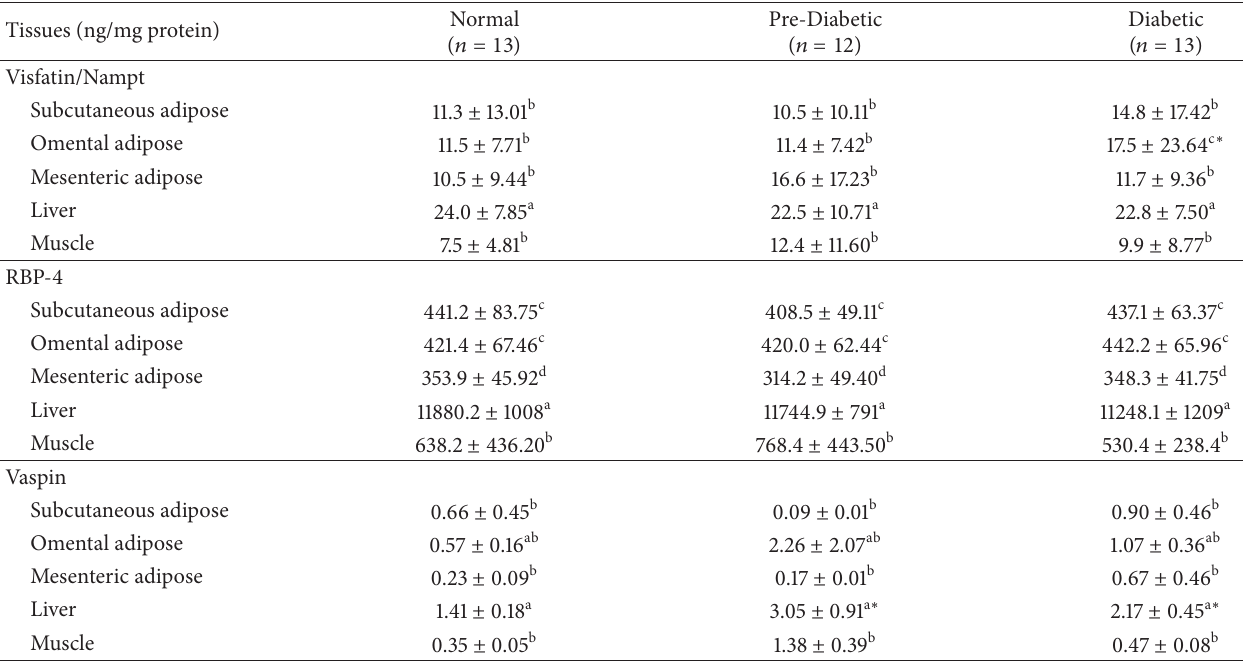
Table 3: Visfatin/Nampt, vaspin, and RBP-4 protein concentrations in different tissues ¥